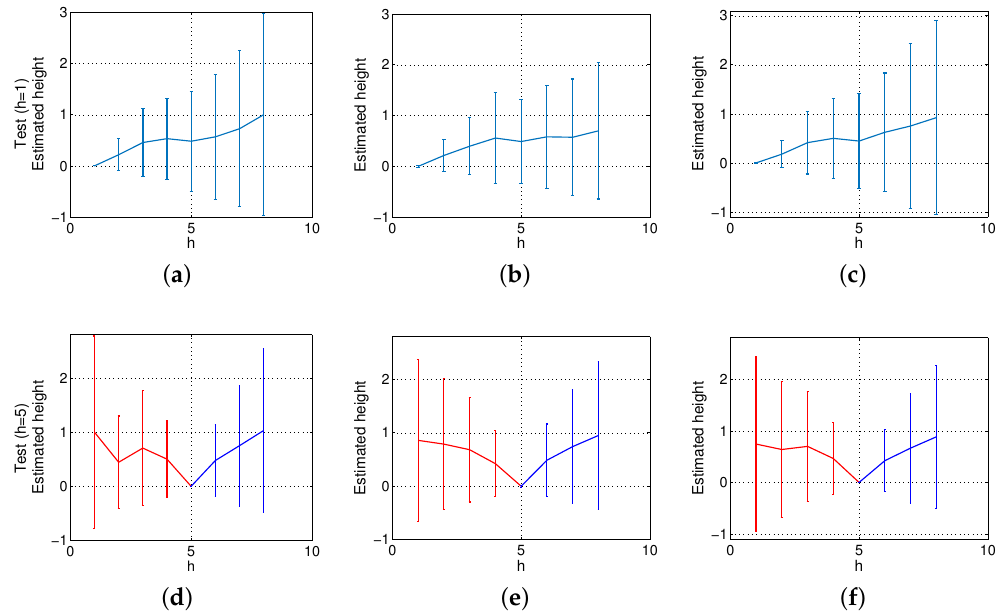
Figure 20. Altitude estimation using the method based on ASIFT and the outdoors dataset. Reference images at the bottom (h = 1) and ( a ) original test images, ( b ) noise added to the test images, and ( c ) occlusions added to the test images. Reference in the middle of the height (h = 5) and ( d ) original test images, ( e ) noise added to the test images, and ( f ) occlusions added to the test